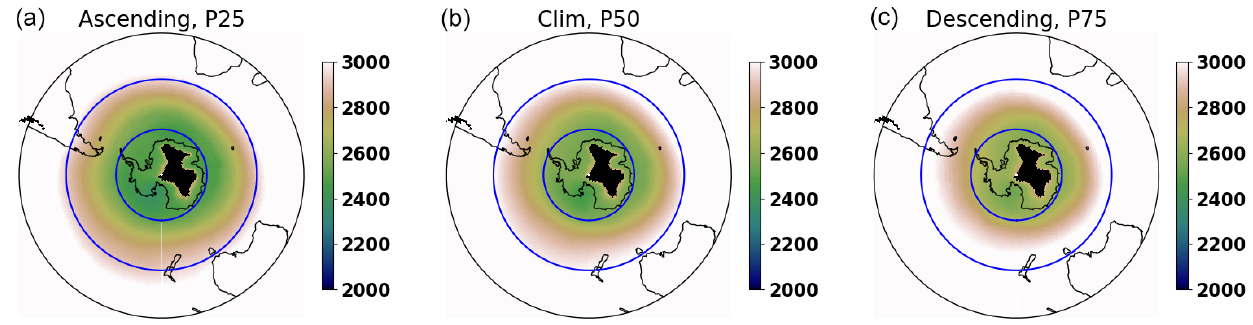
Figure A1. The 700hPa geopotential height distribution corresponding to the three cases (from a to c ): ascending (P25), climatological and descending (P75)